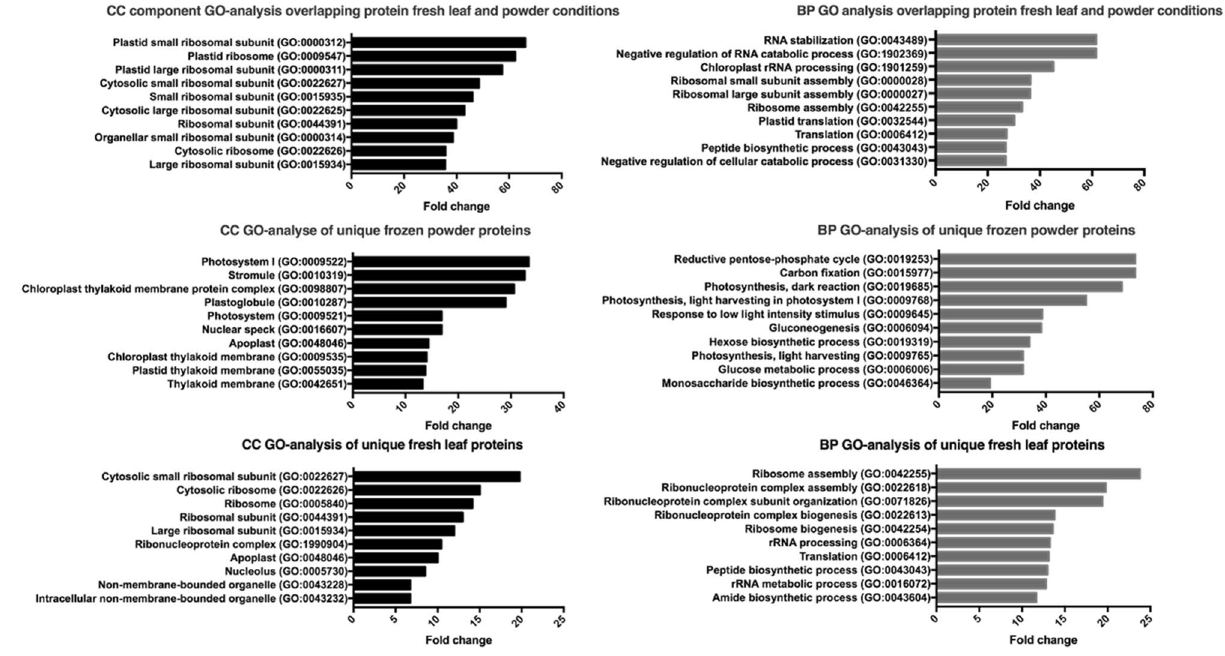
Figure 9. Biological Process (BP) and Cellular Component (CC) GO analysis of the fresh leaf and frozen powder conditions as also their overlap. The 10 highest in terms of enriched fold change are represented for every